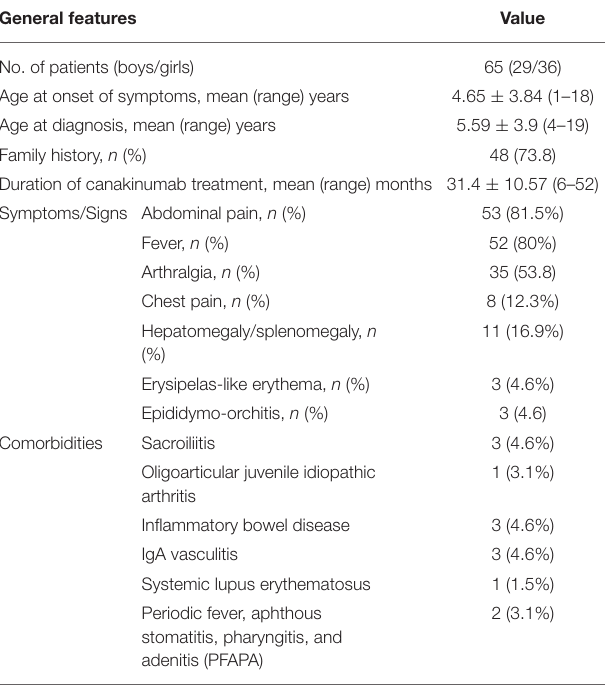
TABLE 1 | Demographic and clinical features of the patients.